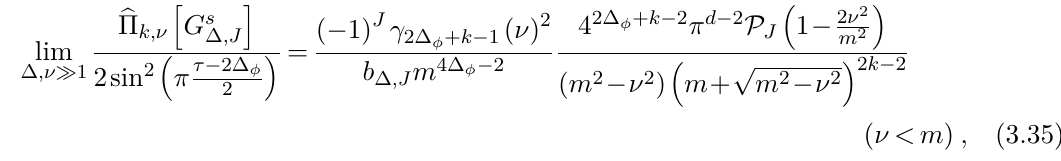
Figure 8. Steepest-descent flows for the absolute value of the function ( x − ) iν 2 ( 1 − x − and ν > m respectively. The two saddle points p − points − 1 , 0 , 1 are in black. The desired integration contour in (3.34) runs between 0 and 1 . In green, we show deformations of this contour to pass through saddle points. For ν < m , the contour is homologous to a steepest descent contour (Lefschetz thimble) through p − point). Near the origin, we choose the contour to spiral many times around 0, so that the function becomes arbitrarily small due to the factor ( x − ) iν/ 2 ∝ e − ν arg x − / 2 . (This is similar to contours described in [67].) In the case ν > m , the dominant saddle is the rightmost one. One of the flows from that saddle ends at the subdominant left saddle. From there, the contour approaches the origin and spirals around 0 in a similar way to the case ν < m